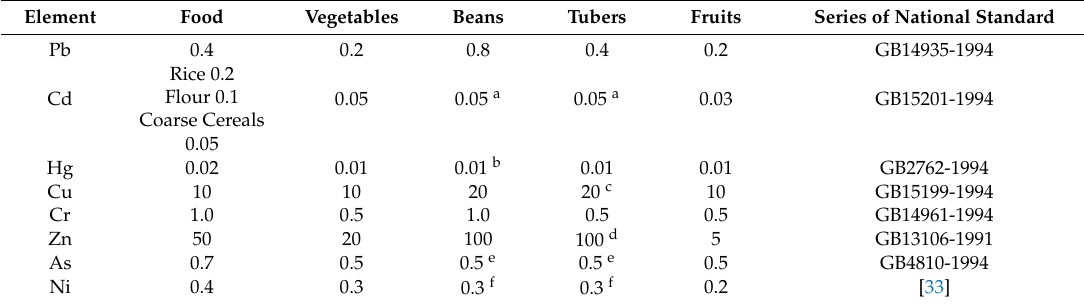
Table 3. National hygienic standard value of heavy metal (HM) content in food in China